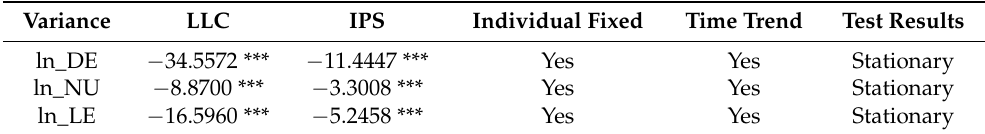
Table 4. Data stationarity test.